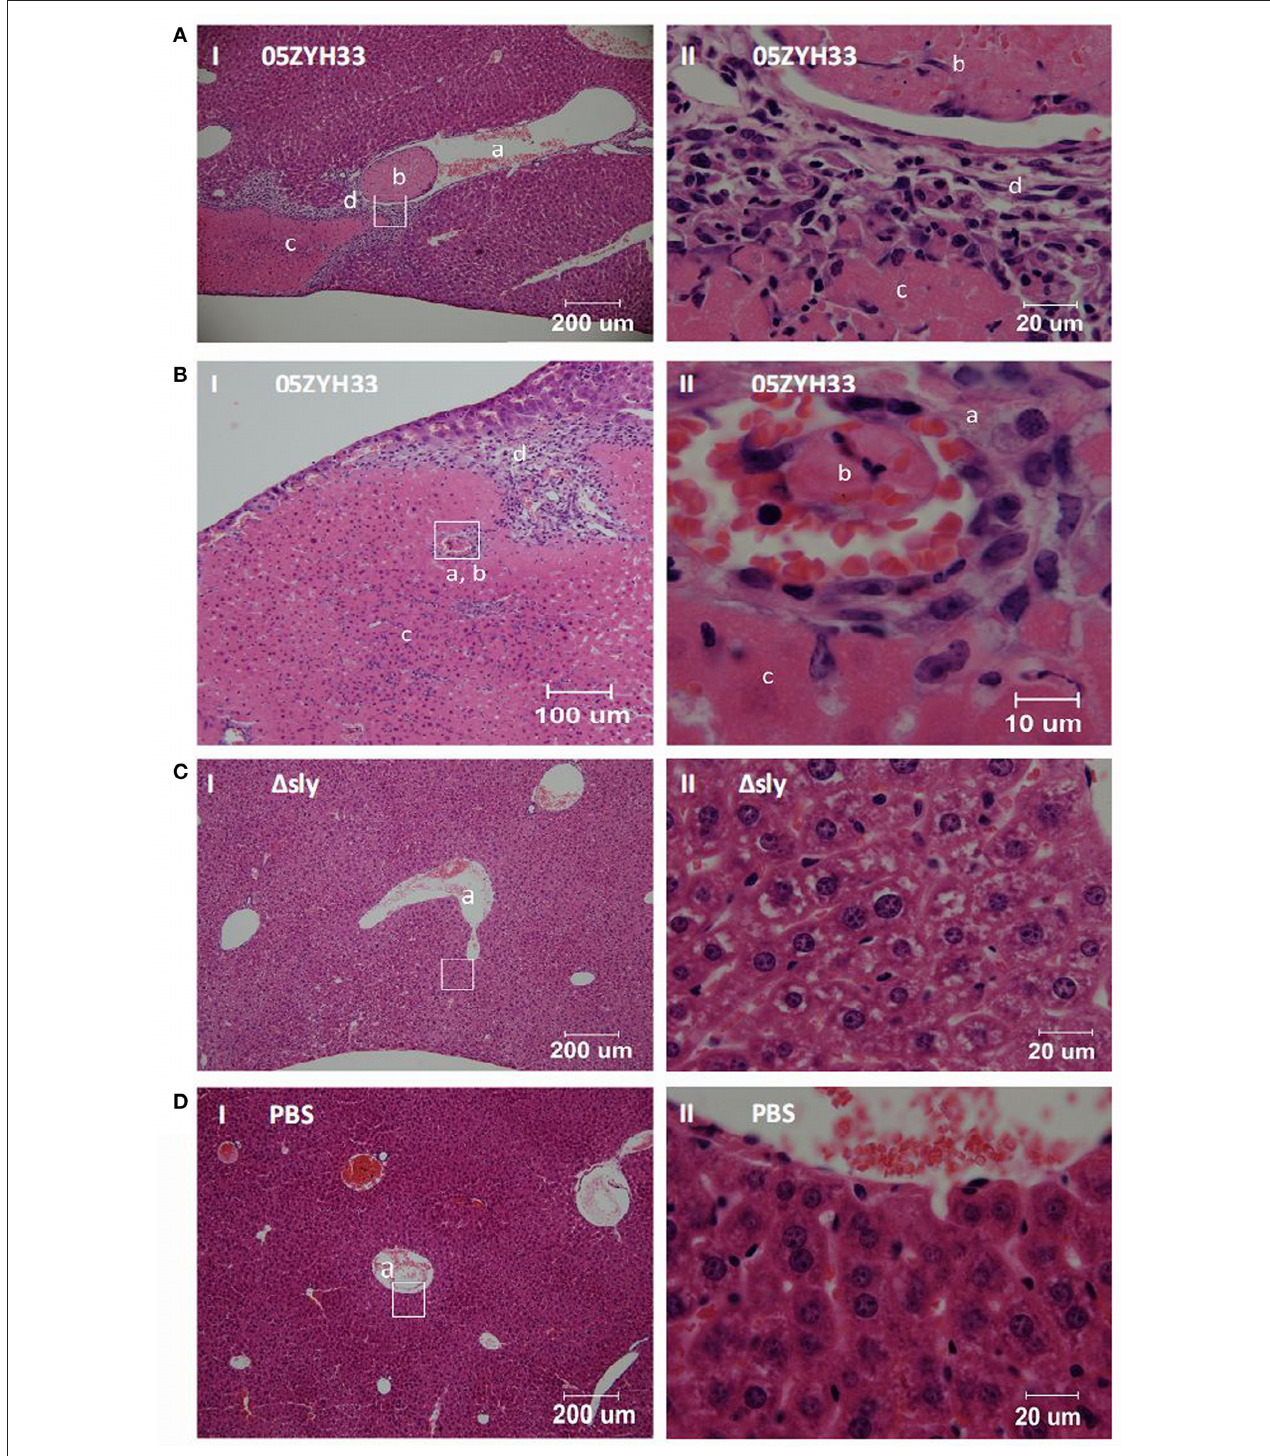
FIGURE 6 | SLY contributes to the intravascular thrombosis and its associated liver injury caused by S. suis . Female BALB/c mice (6–8 weeks old) were challenged with (A,B) 05ZYH33; (C) mutant 1 sly ( ∼ 1 × 10 8 CFU); (D) PBS control through the caudal vein. Pathological changes were observed by hematoxylin and eosin pathological staining of tissue sections at 48h post-inoculation. Panels numbered II are the enlarged images from the white boxes in panels numbered I . a, b, c , and d in the panels represent blood vessels, intravascular thrombosis, coagulative necrosis, and leukocyte infiltration, respectively.